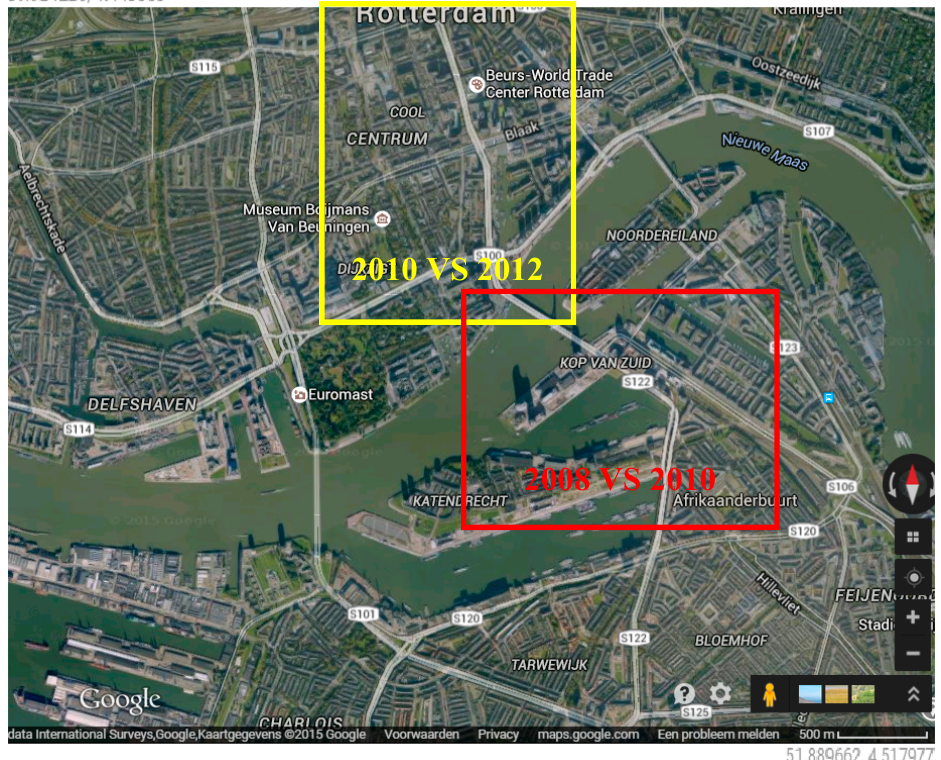
Figure 10. Locations of test areas and their data sets. (From Google earth and the coordinates are approximately measured from the map).